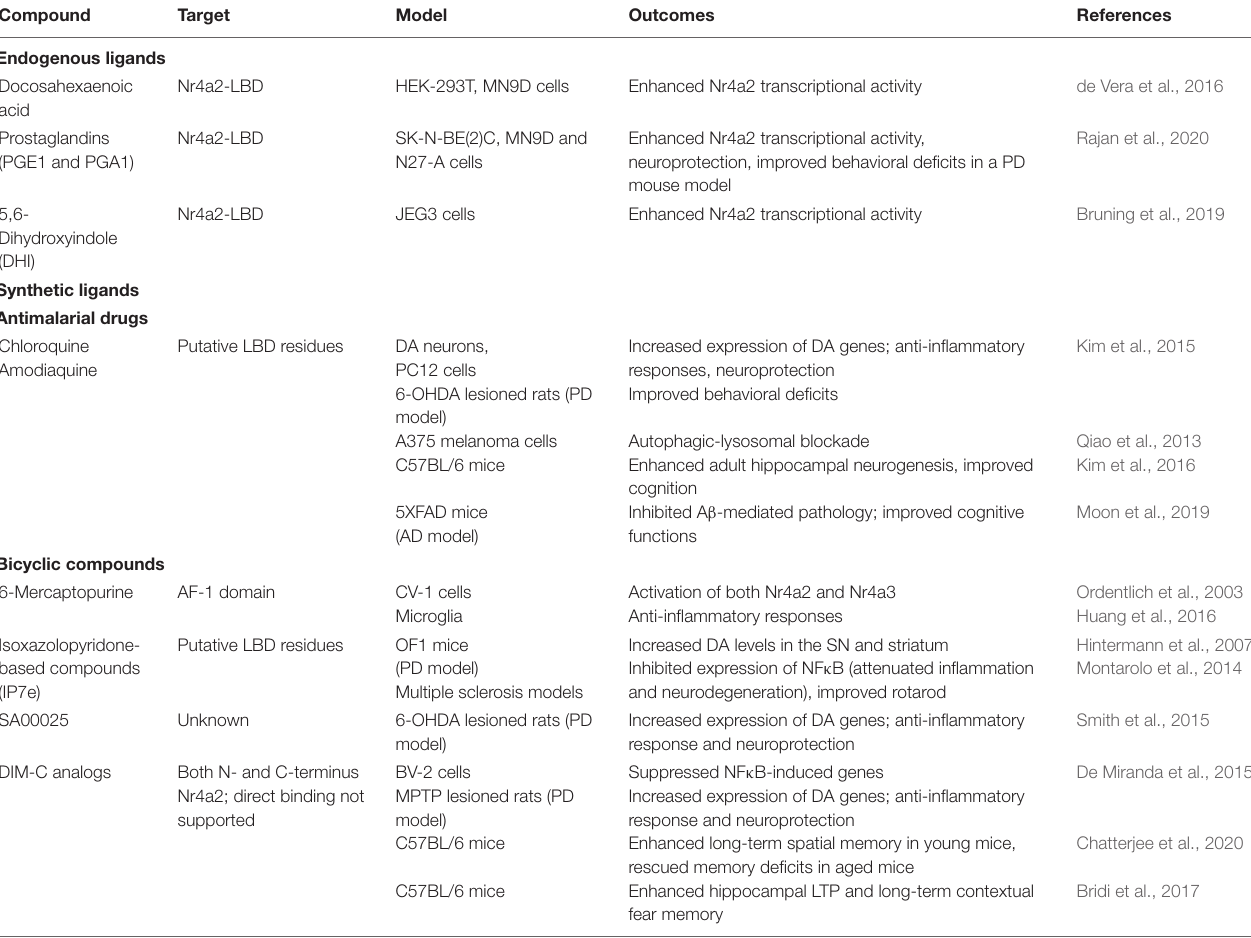
TABLE 2 | Features of synthetic and endogenous Nr4a2